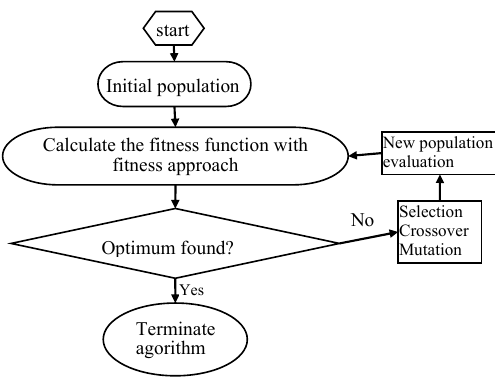
Figure 2. Schematic representation of the optimization rationale for genetic algorithm (GA).